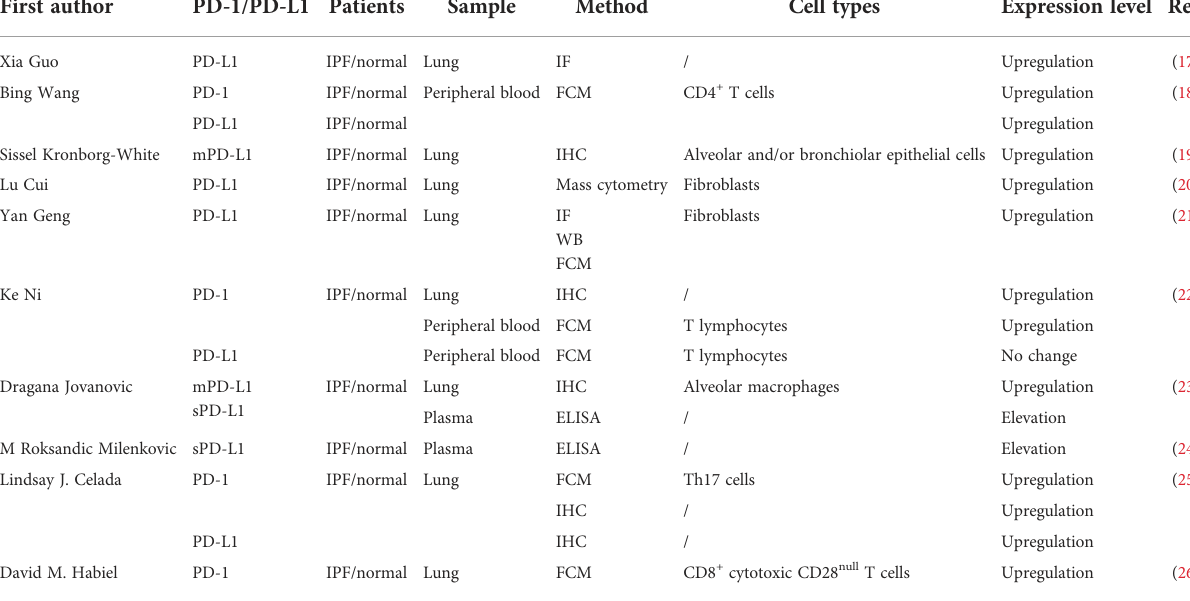
TABLE 1 The expression level of the PD-1/PD-L1 in human